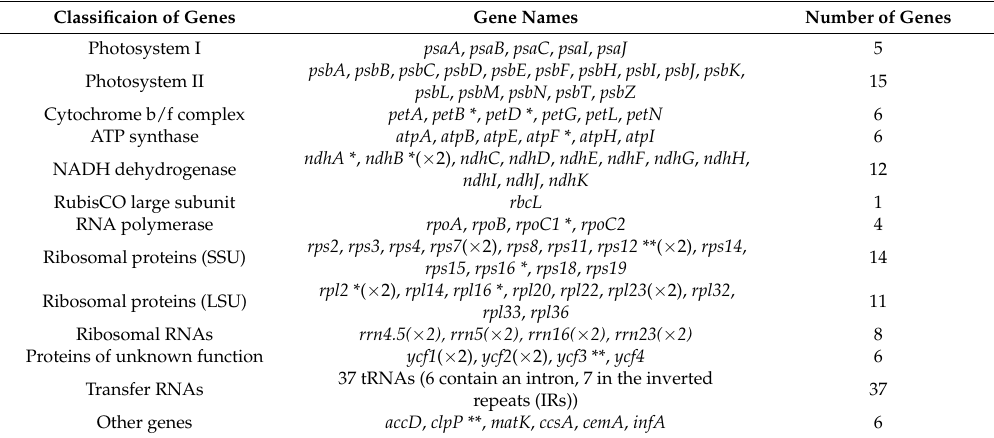
Table 2. Gene contents in the chloroplast genomes of P. rhoeas and P. orientale